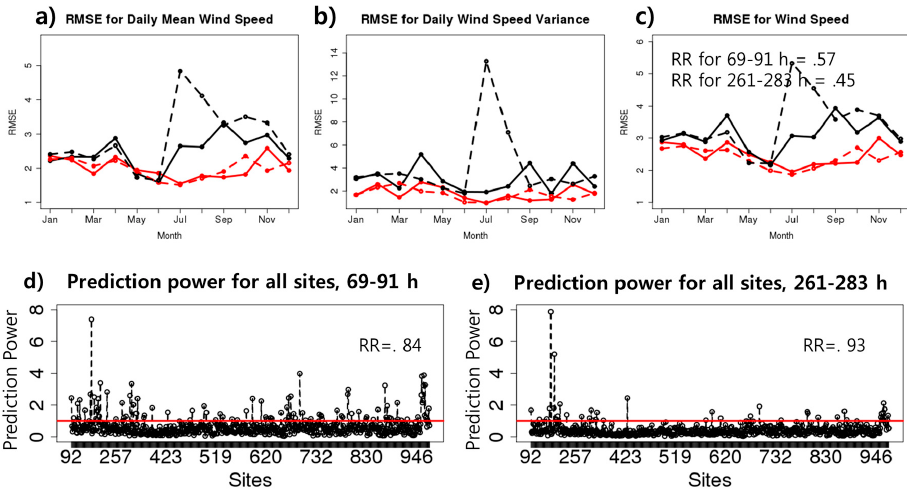
Figure 6. Bias-corrected results for daily wind speed. ( a ) RMSE of the daily wind speed mean, ( b ) RMSE of daily wind speed variance, and ( c ) total wind speed RMSE: 69–91 h uncorrected (solid black line), 69–91 h corrected (solid red line), 261–283 h uncorrected (dashed black line), 261–283 h corrected (dashed red line). The ratio of root mean square (‘RR’) for each time slot is in the middle. The ratio of mean corrected RMSE to uncorrected RMSE for each site in ( d ) the 69–91 h range and ( e ) the 261–283 h range.